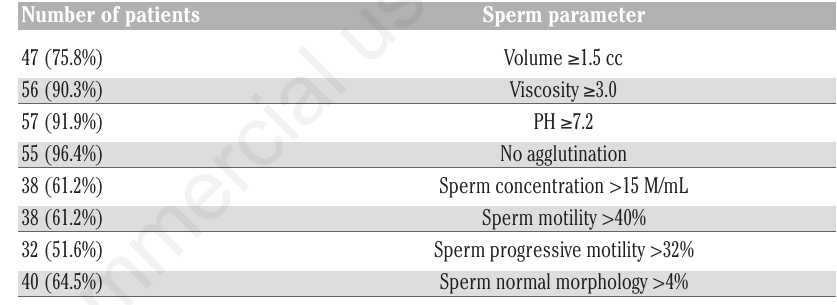
Table 1. The characteristics of patients’ sperm parameters.